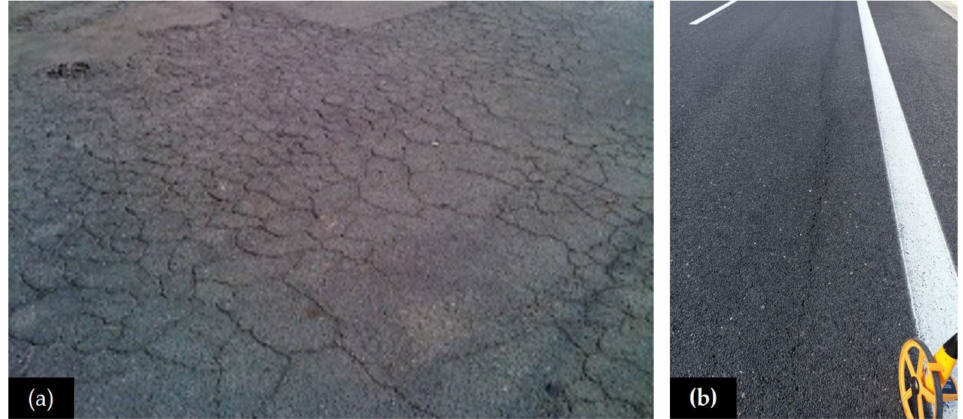
Figure 7. Examples of ( a ) alligator cracking and ( b ) longitudinal